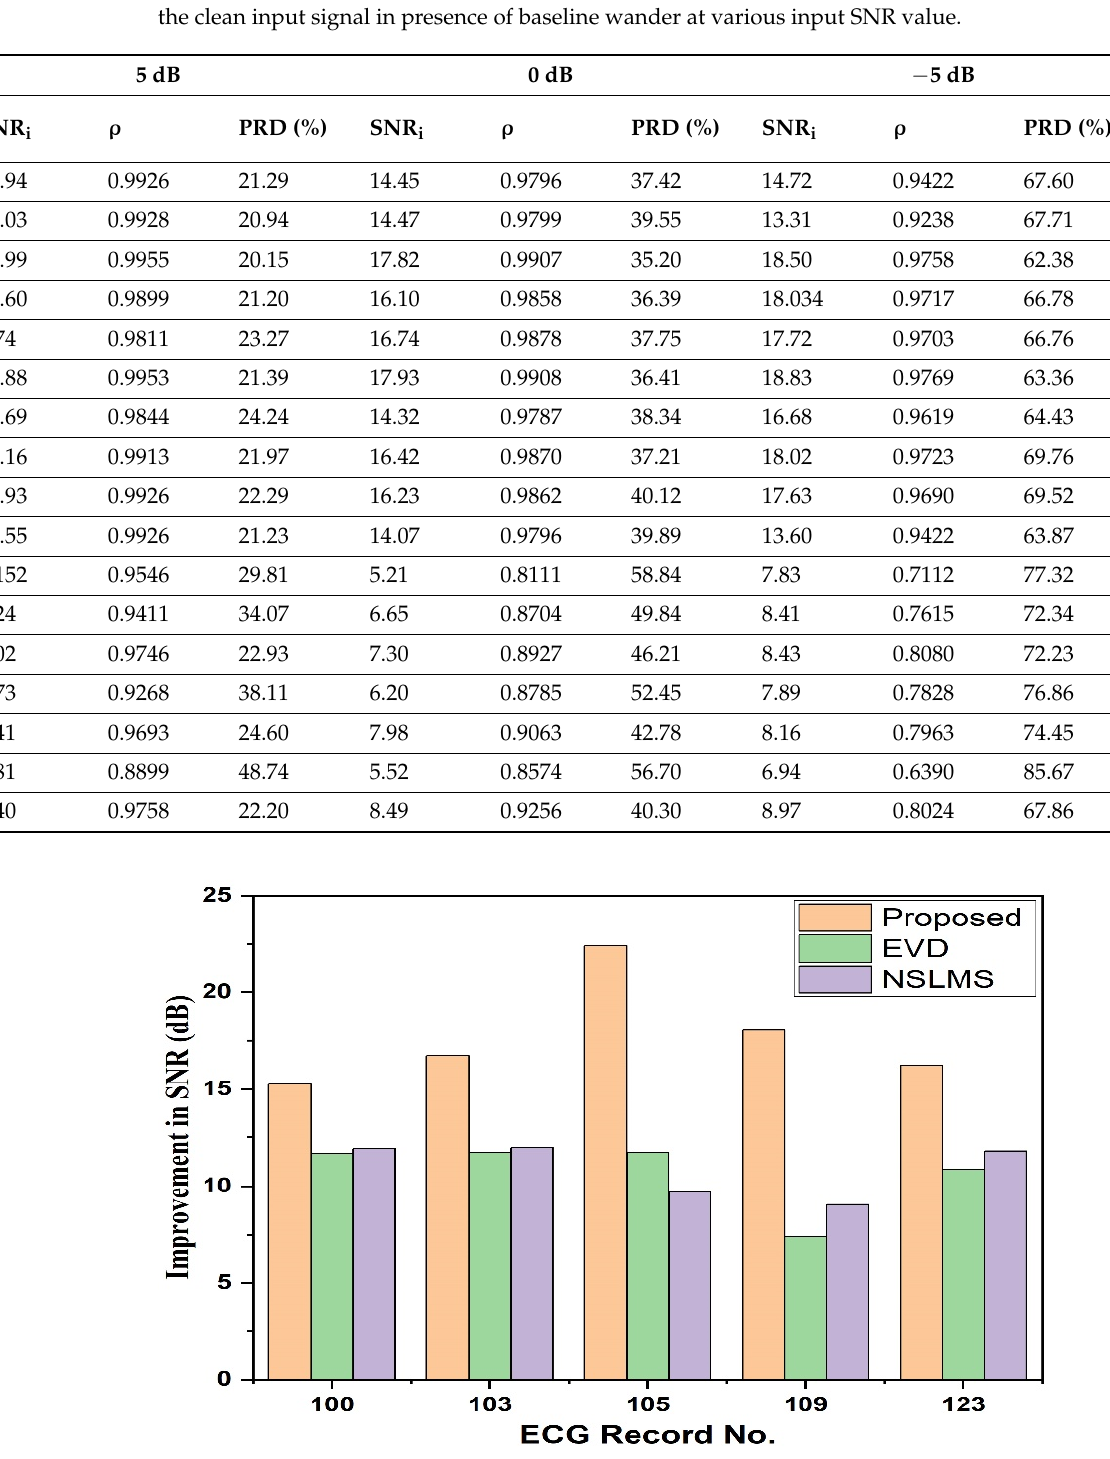
Figure 10. Comparison of the proposed method with EVD and NSLMS methods in eliminating baseline wander in terms of the improvements in the SNR values at 0 dB input SNR. The comparison drawn in Figures 9 and 10 reveals that the proposed method generates better signal quality in comparison to some of the state-of-the-art methods. The proposed method fetches excellent results when implemented to remove both PLI as well as baseline wander simultaneously. Figures 11–13 collect the average improvements in SNR values, cross-correlation coefficients and PRD values. Moreover, the results are compared with various other methods for each record at different input SNR values in presence of 50 Hz PLI along with baseline wander [5–7,54].